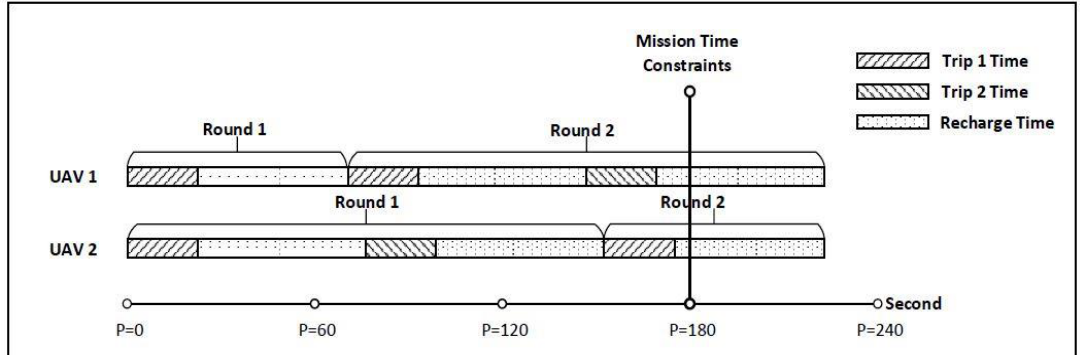
Figure 1. An example of timing diagrams of two rechargeable